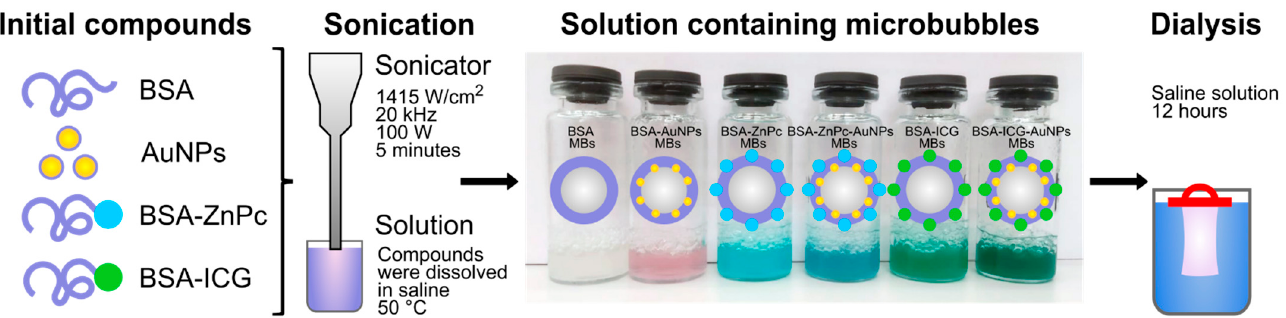
Figure 1. Scheme of microbubbles production by sonication method: bovine serum albumin (BSA) was used as the key component for the shell preparation, such compounds as BSA-coated gold nanoparticles (AuNPs) and conjugates of BSA with photodynamic dyes, zinc phthalocyanine (ZnPc) and indocyanine green (ICG), (BSA-ZnPc and BSA-ICG) were used for further bubbles’ shell stabilization. All compounds were dissolved in saline and then obtained solutions were sonicated for 5 min to obtain microbubbles. Resulting microbubbles with BSA shell (BSA MBs), shell stabilized with AuNPs only (BSA-AuNPs MBs), shell stabilized with BSA-ZnPc/BSA-ICG conjugates only (BSA-ZnPc MBs, BSA-ICG MBs, respectively), and shell stabilized both with conjugates and AuNPs (BSA-ZnPc-AuNPs MBs, BSA-ICG-AuNPs MBs) were then dialyzed in saline to remove free components from the